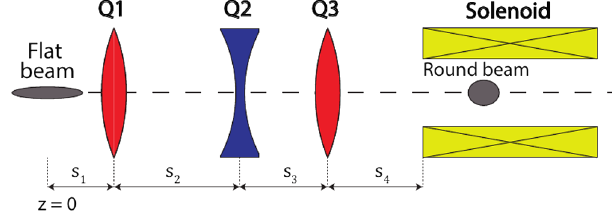
FIG. 1. General geometry of quadrupole triplet for FTR beam